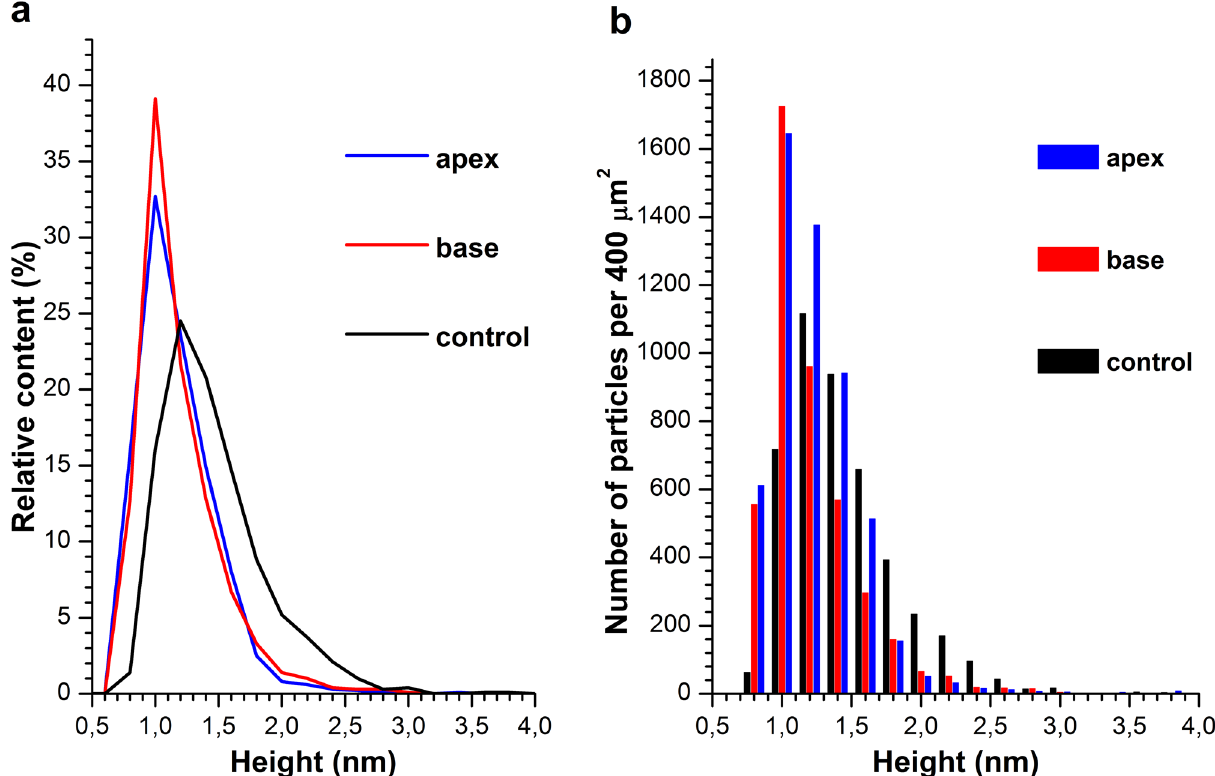
Figure 2. Density function ρ ( h ) plots ( a ) and the number of the AFM-visualized objects per 400-µm 2 area vs. height ( b ) obtained in control experiments (black line and bars) and after 40-min incubation of the HRP solution in the vicinity of the apex of the pyramid (blue line and bars) or in the center of its base (red line and bars).